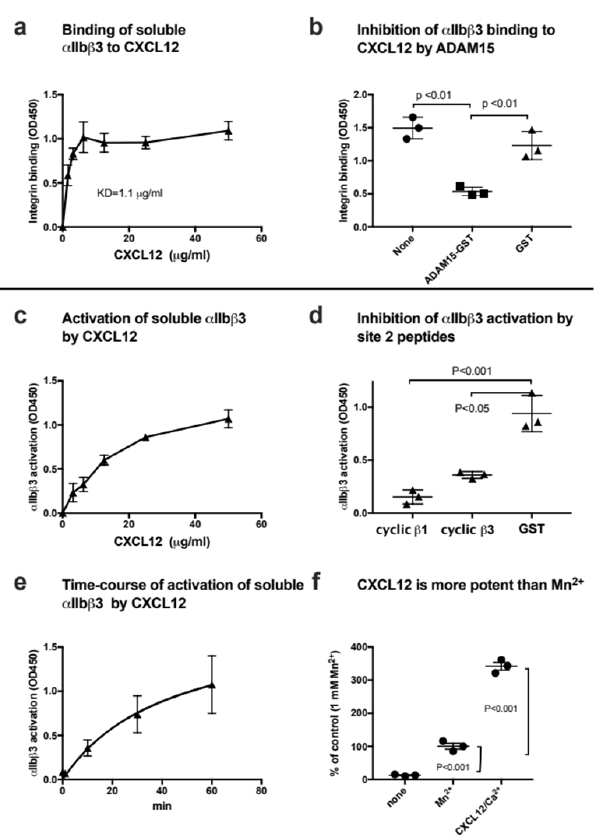
Figure 4. CXCL12 binds to and activates soluble integrin αIIbβ3 in cell -free conditions. ( a )